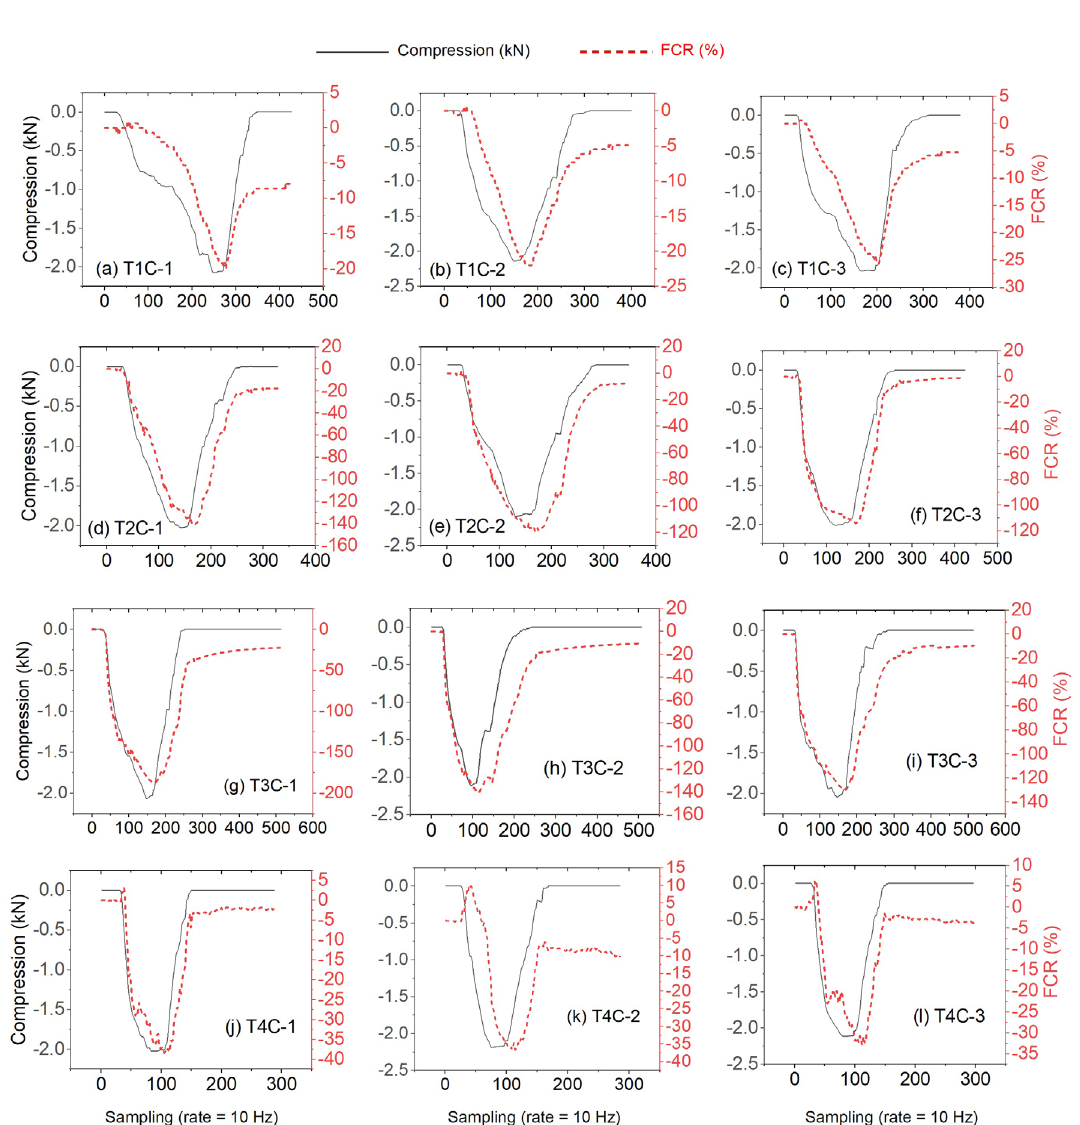
Figure 8. Compressive force values and the FCR in each mix and repetition test for T1C (a, b, c), T2C (d, e, f), T3C (g, h, i) and T4C (j, k,